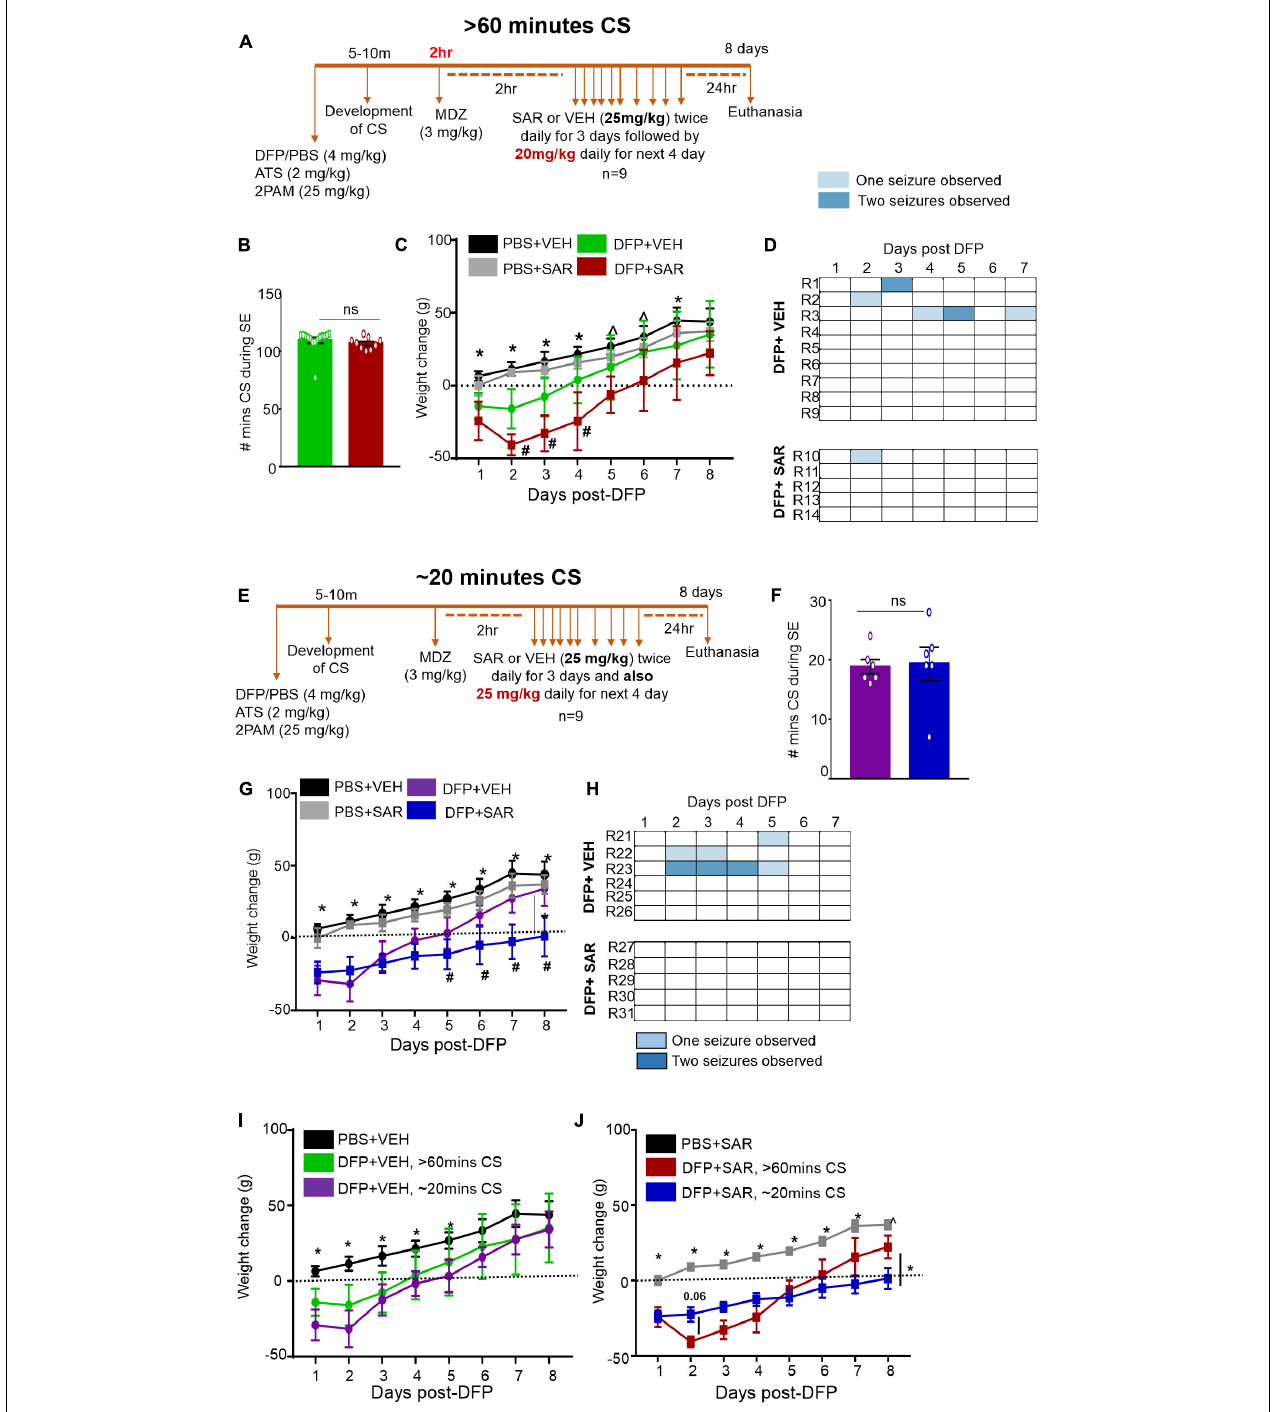
FIGURE 2 | Experimental timelines, SE severity, bodyweight and observed spontaneous seizures mitigation by saracatinib (SAR) during 7 days post-DFP intoxication. (A) Experimental timeline for animals with > 60-min CS. (B) There was no significant difference between the number of minutes of CS during SE between vehicle and SAR treated groups ( t -test, n = 9-15). (C) Change in bodyweight over the 7 days post DFP (mixed measures ANOVA, n = 9-14). (D) Heat-map representation of the number of SRS per day. (E) Experimental timeline for animals with ∼ 20-min CS. (F) There was no significant difference between the number of minutes of CS during SE between vehicle and SAR treated groups ( t -test, n = 6). (G) Change in bodyweight over the 7 days post DFP (mixed measures ANOVA, n = 5-6). (H) Heat-map representation of the number of SRS per day. (I,J) Change in bodyweight comparisons between > 60-min and ∼ 20-min CS groups in DFP + VEH and DFP + SAR groups (mixed measures ANOVA, n = 5-15). * p < 0.05 both DFP compared to controls, ˆ p < 0.05 DFP + SAR group compared to controls, # p < 0.05 DFP + VEH compared to DFP + SAR group. Error bars indicate standard error of the mean.